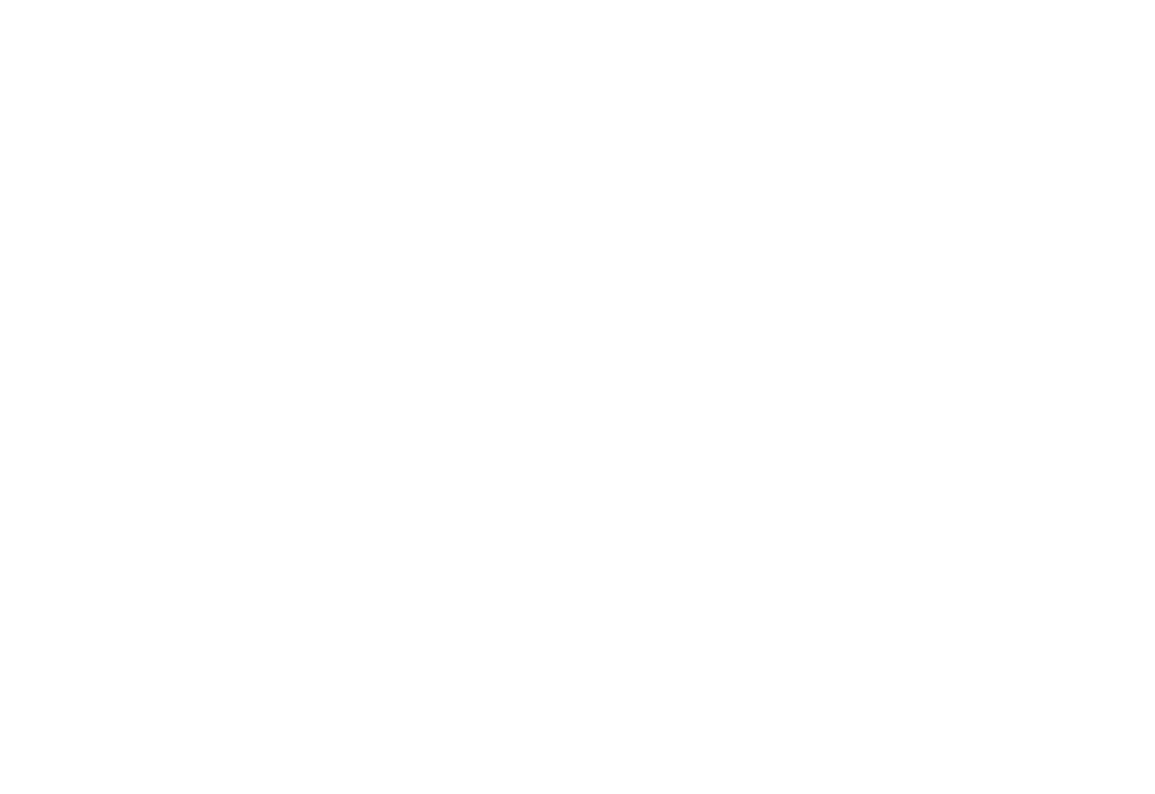
PLOS ONE | https://doi.org/10.1371/journal.pone.0273277 August 16, 2022 2 /